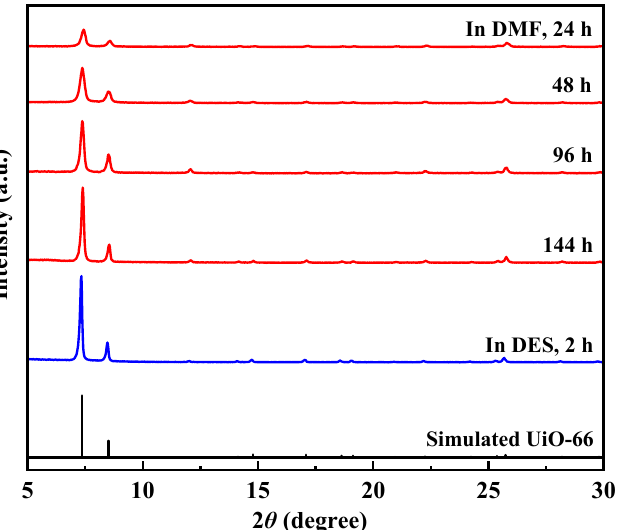
Figure 3. XRD patterns of simulated UiO-66 and the UiO-66 synthesized in DMF with different reaction time and in DES with reaction time of 2 h.